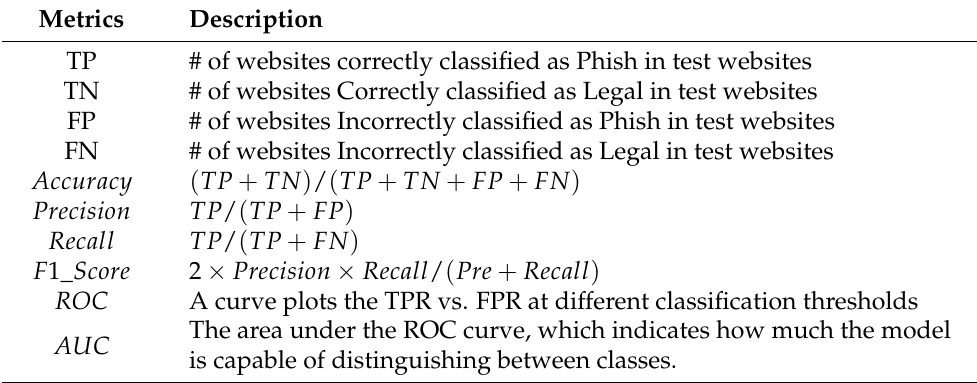
Table 4. Metrics involved in perfomance evaluation of phish detection methods.